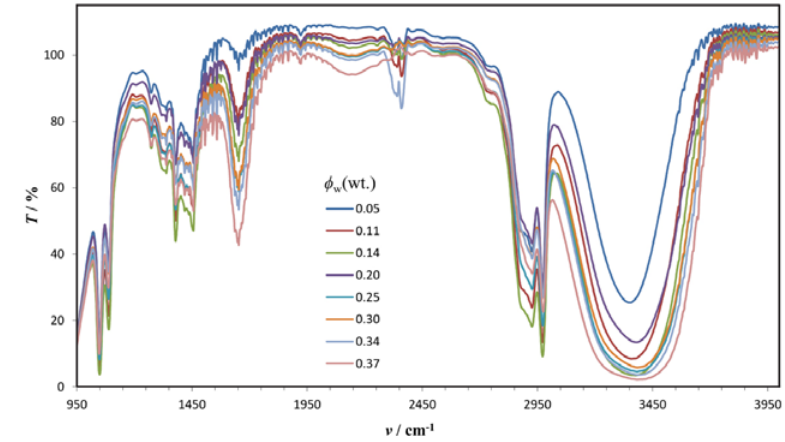
Figure 6. FT-IR spectra of microemulsions along the dilution line R